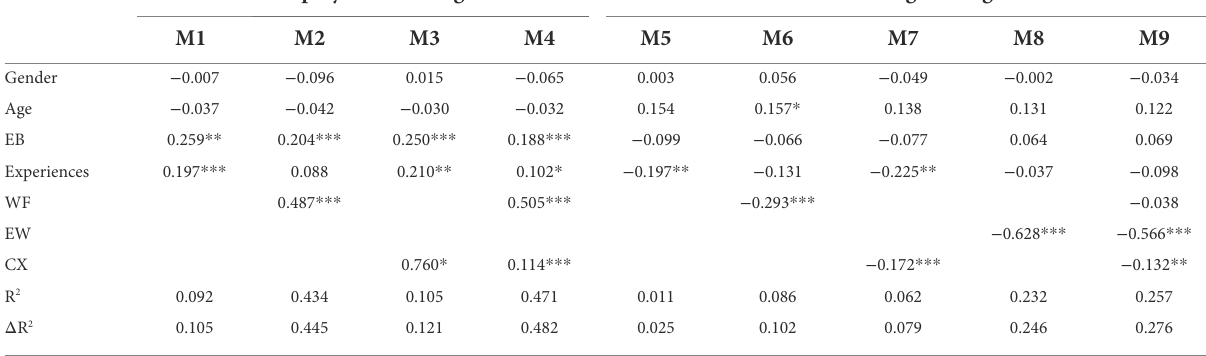
TABLE 3 The mediating